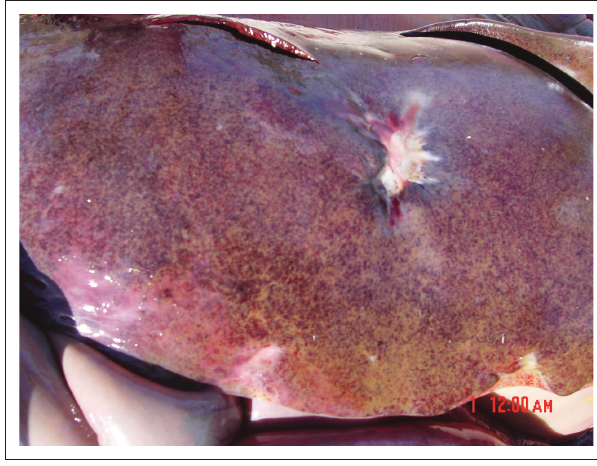
Source : Photo taken by R.G. Bengis FIGURE 3: Macroscopic appearance of zebra liver following death from cyanobacterial intoxication.